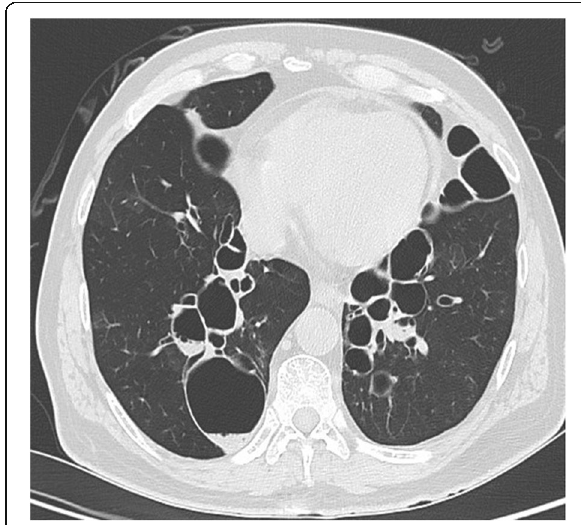
Fig. 1 Non-contrast chest CT, showing cystic bronchiectasis in both